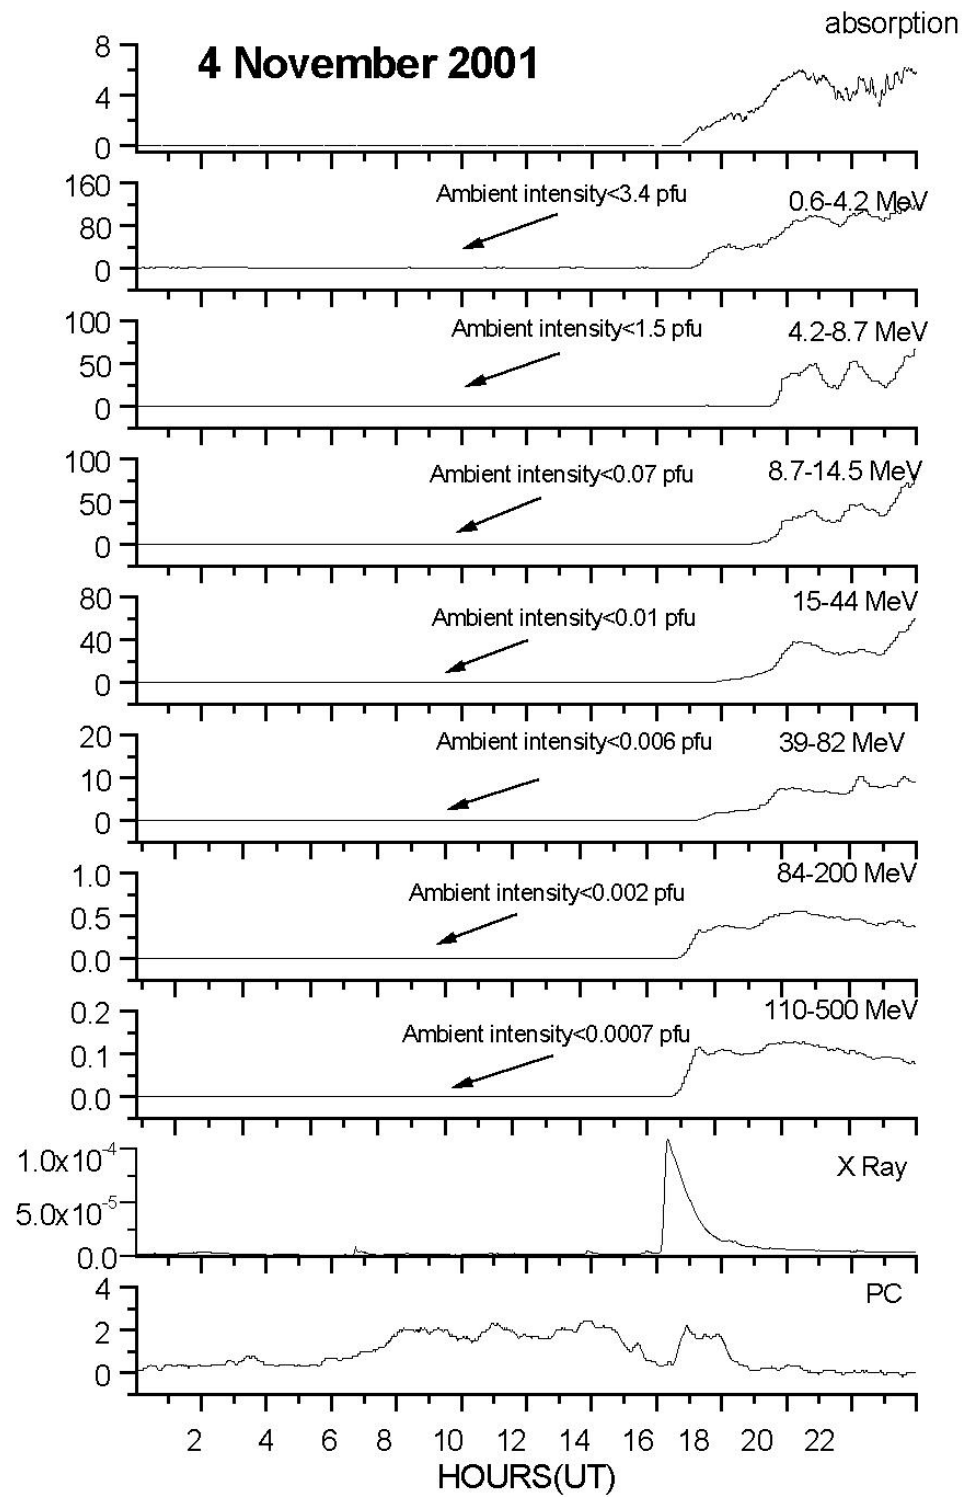
Fig. 2. As Fig. 1, but for 4